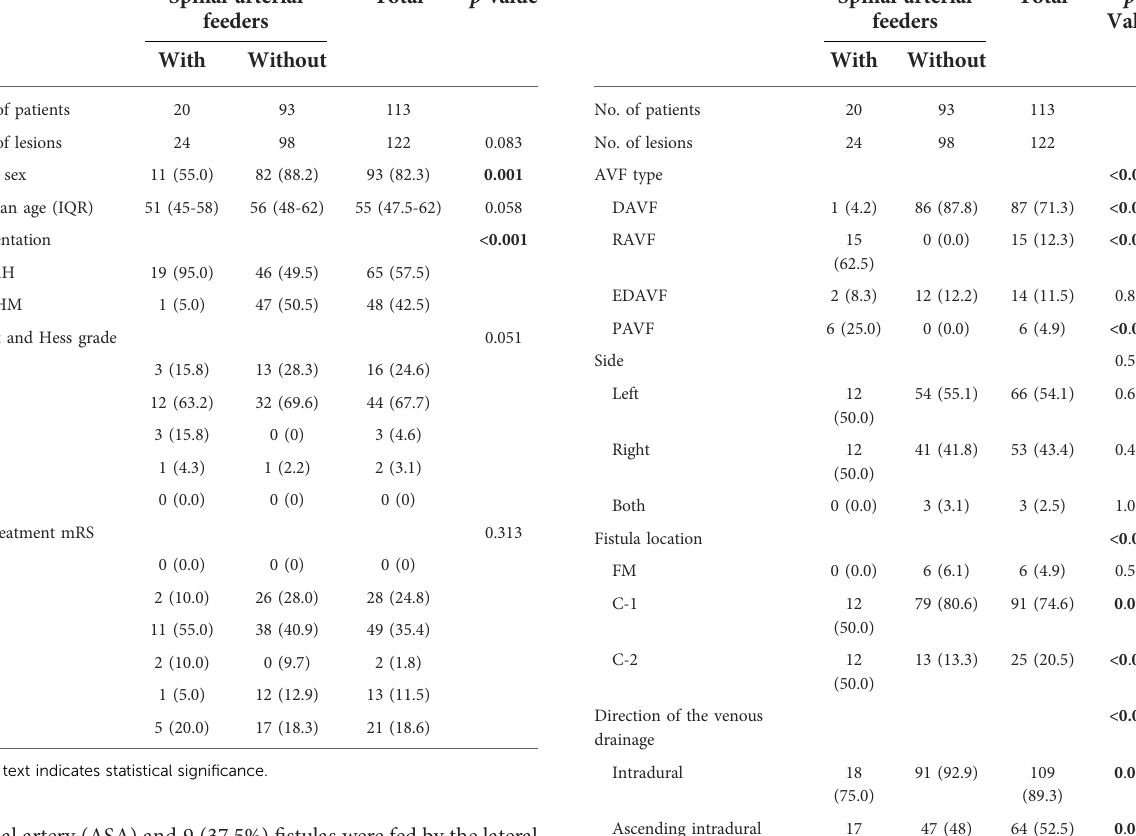
TABLE 2 Angioarchitecture according to spinal arterial feeders.